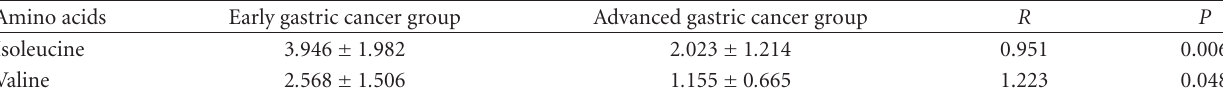
Table 2: Urine amino acid profiles of early and advanced gastric cancer groups [ R = (early gastric cancer group − advanced gastric cancer group)/advanced gastric cancer group].